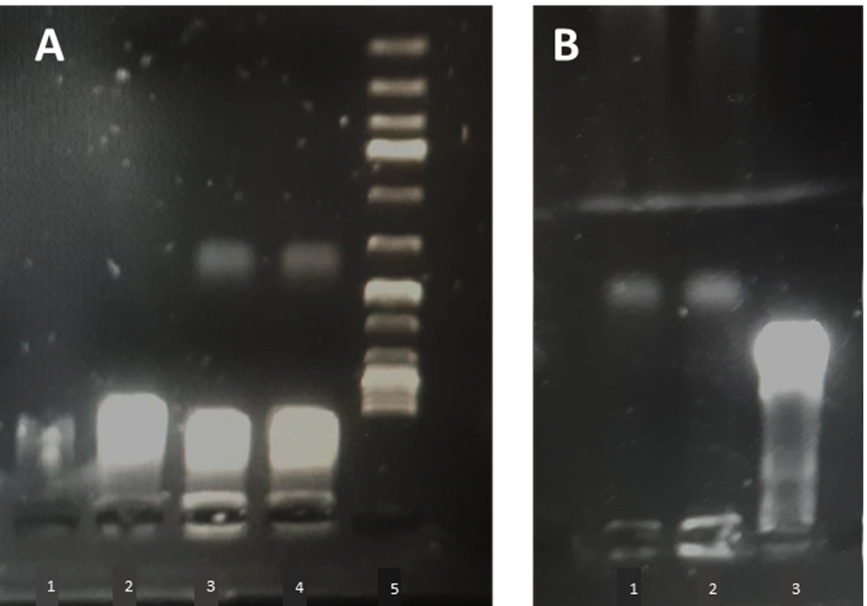
Figure 7. ( A ) Agarose gel electrophoresis of pCMVkan-S in C-MEM (1), pCMVkan-S in PBS (2), DOTAP4/pCMVkan-S N/P ratio 1:1 (3) and 0.25:1 (4), and DNA ladder of 1 kbp at RT after 15 min dilution in C-MEM (5). ( B ) Agarose gel electrophoresis of DOTAP4/pCMVkan-S N/P ratio 0.25:1 (1) and 1:1 (2) and pCMVkan-S diluted in PBS (3), after 37 °C, 24 h incubation.